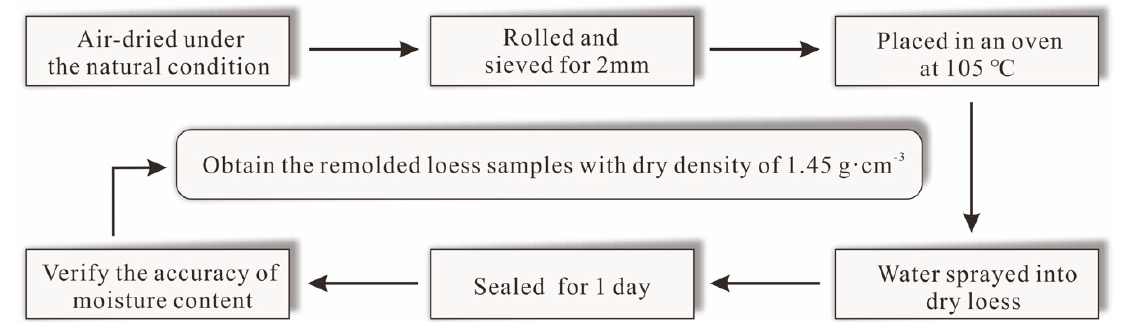
Figure 2. The process of the remolded loess specimen preparation.